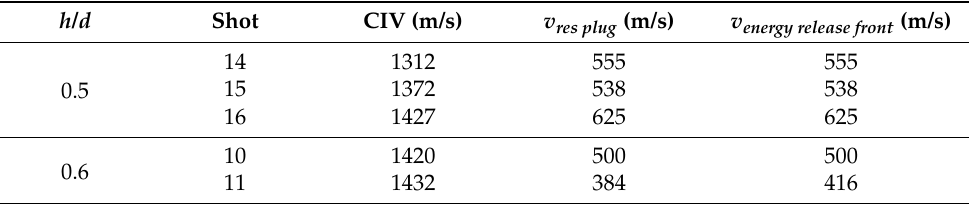
Table 5. Summary of parameters for the RI equation.